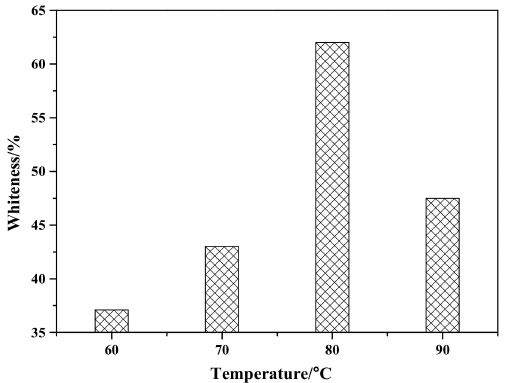
Figure 4. The e ff ect of reaction temperature on whiteness of ZCFA